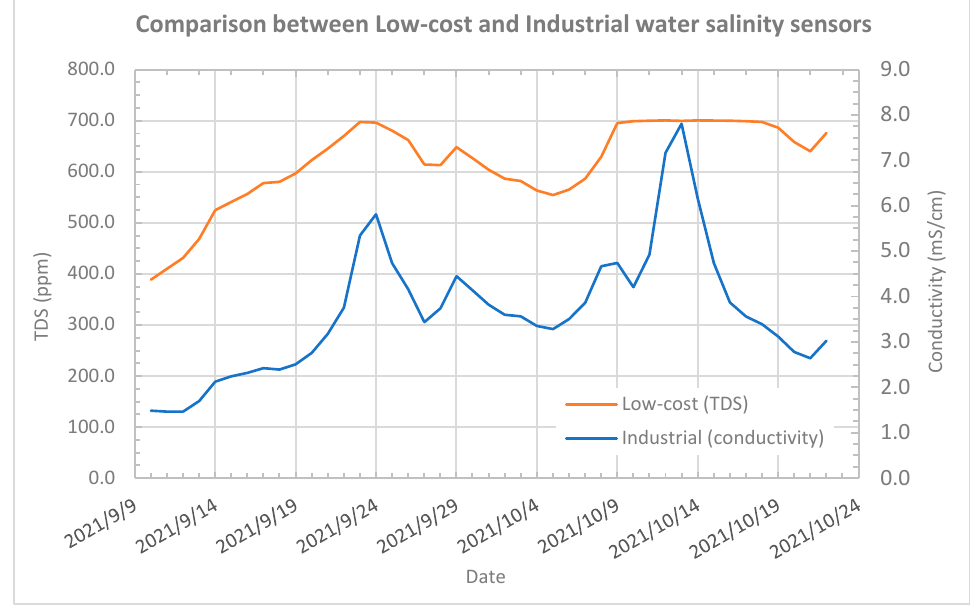
Figure 7. Comparison between the low ‐ cost TDS and industrial EC sensors to determine water sa ‐